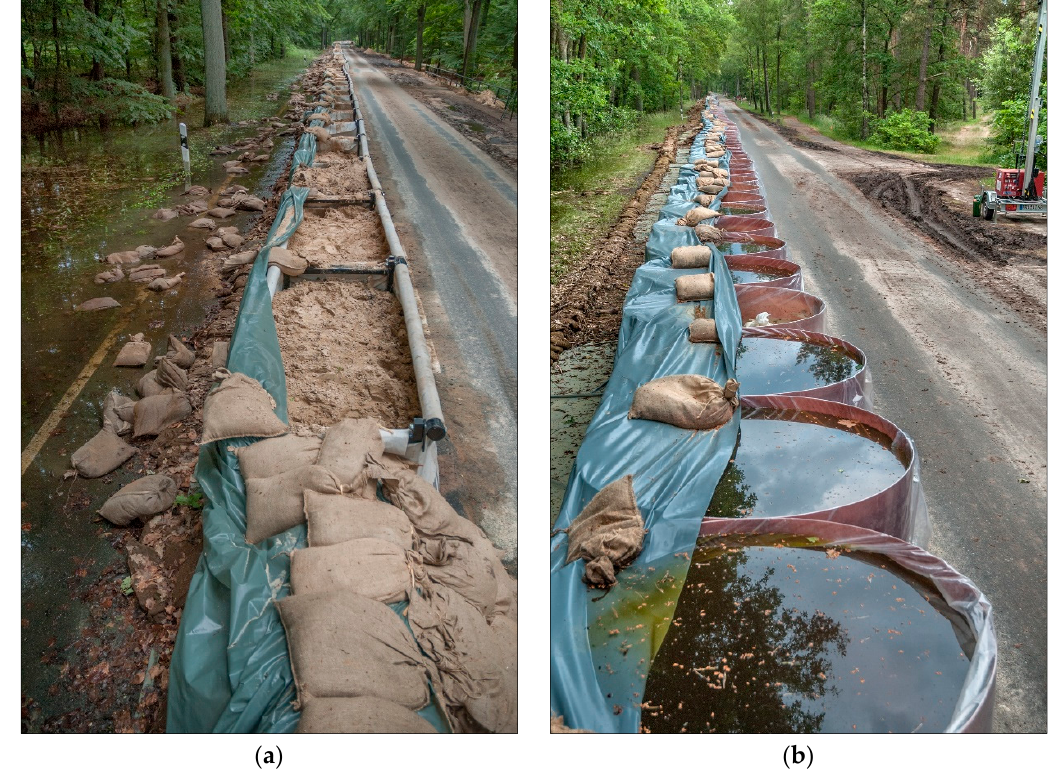
Figure 2. SBRSs near Gartow (Lower Saxony, Germany) after the Elbe flood waters had receded in 2013: ( a ) QUICK-DAMM type E ( b ) AQUARIWA.